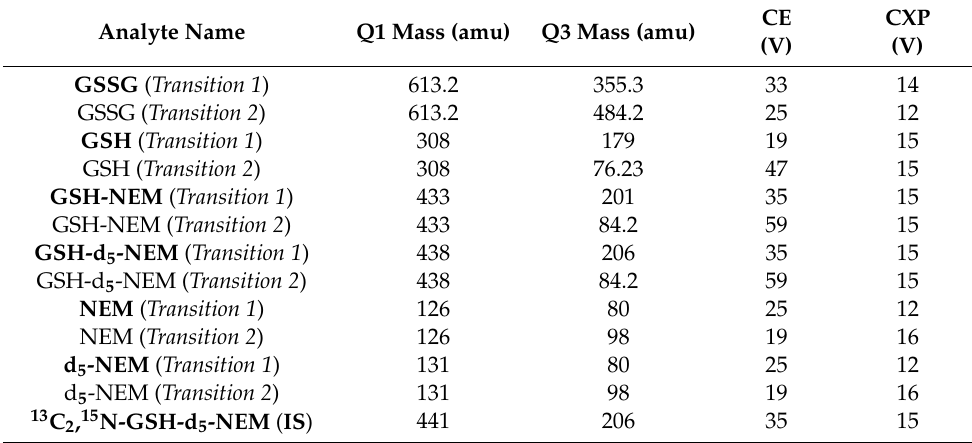
Table 1. MRM transitions and parameters per analyte. For each compound, transition 1 (marked in bold) was used for quantification. Dwell time was 35 ms. CE: collision energy; CXP: collision cell exit potential; IS: internal standard.